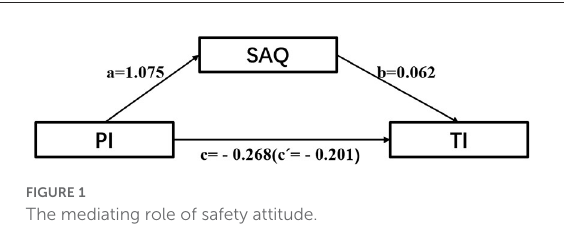
FIGURE1 The mediating role of safety attitude.